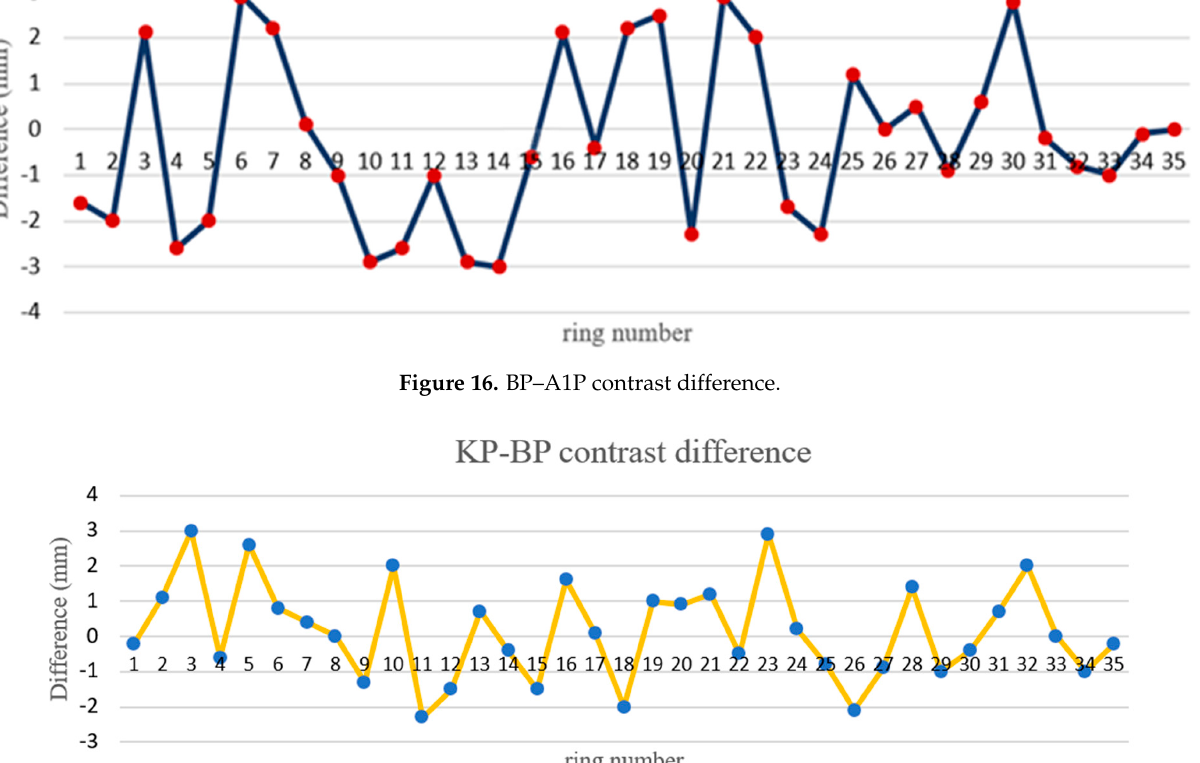
Figure 17. KP–BP contrast difference.